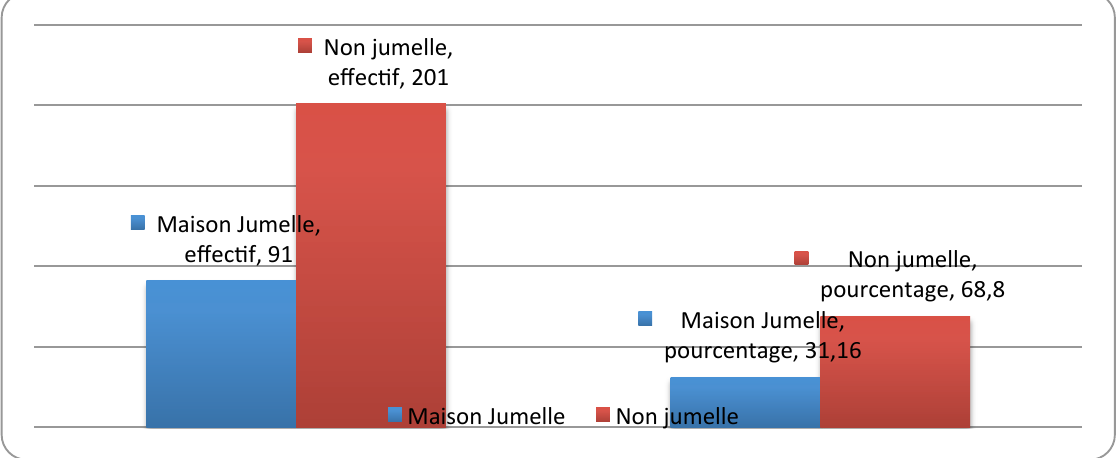
Figure 6. Type de maisons de la Gécamines